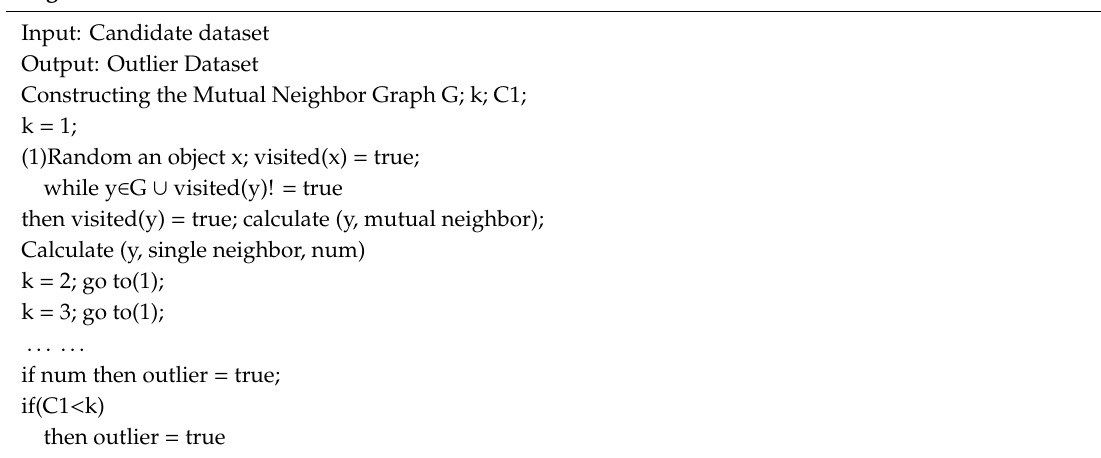
Algorithm 2. Parameter-free outlier detection